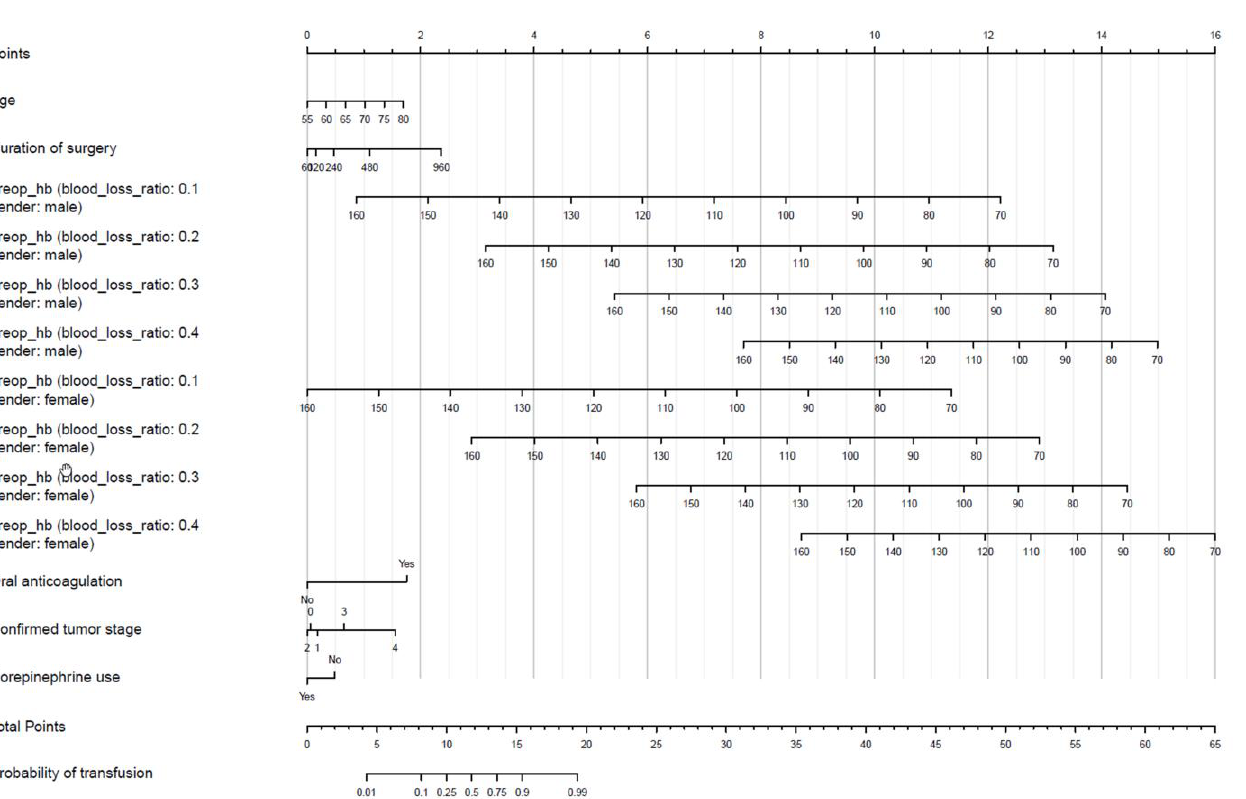
Figure 2. Nomogram of the logistic regression model to predict early perioperative blood transfusion.